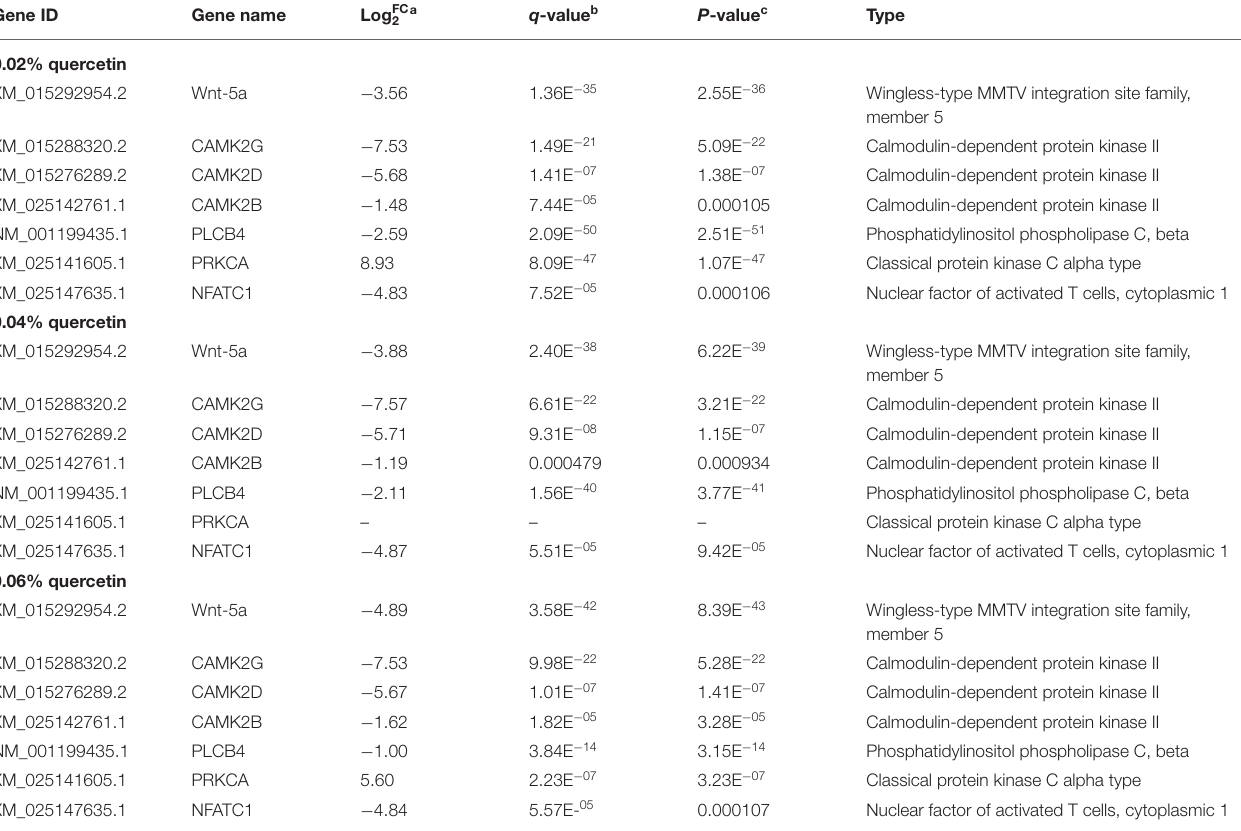
TABLE 7 | Important differentially expressed genes in the Wnt signaling